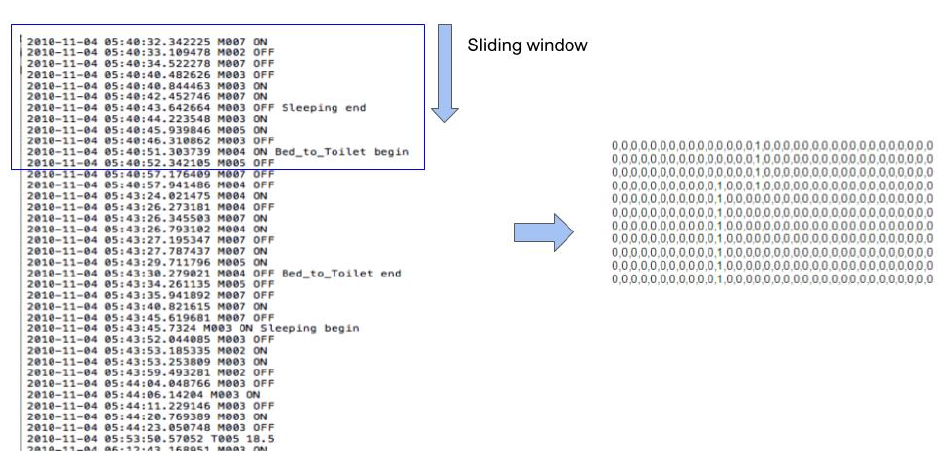
Figure 4. Raw sensor representations are segmented by applying a sliding window, with different time windows.